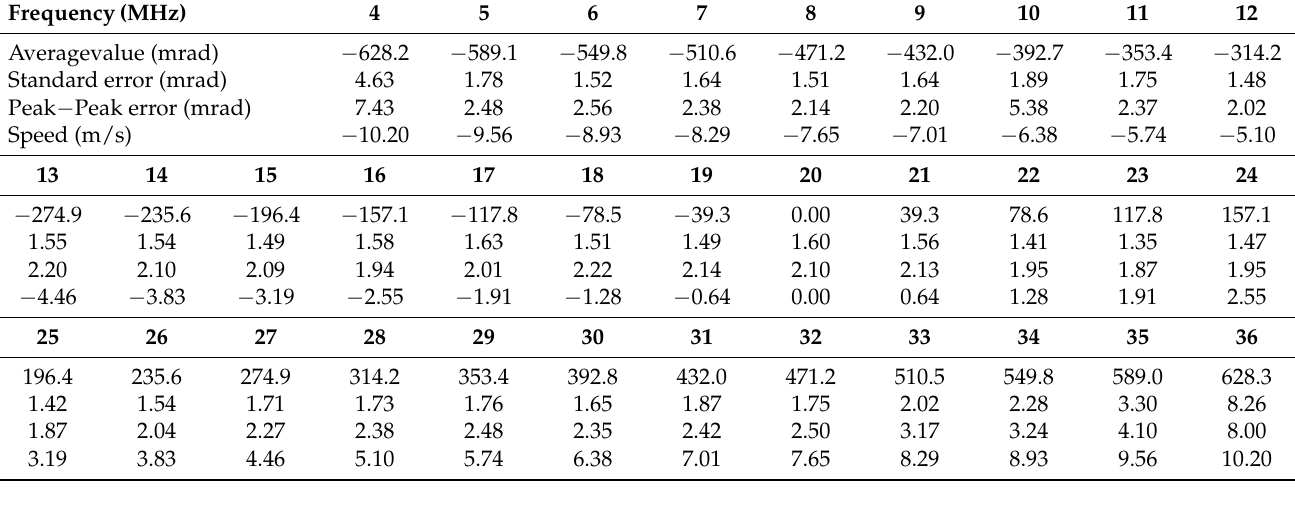
Table 2. Phase increment errors in phase resolution algorithms with dynamic filters at different measuring signal frequency.